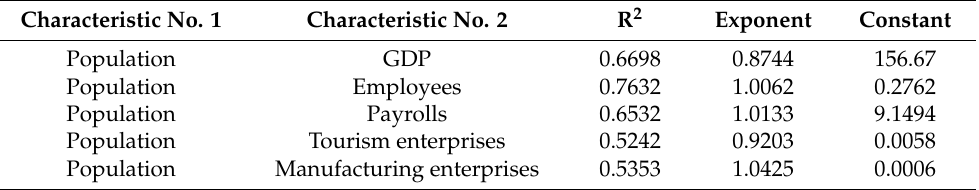
Figure 1. The 2016 association between population numbers and enterprise numbers in United States micropolitan statistical areas. Table 2. Power-law associations between population numbers and different economic and en- trepreneurial characteristics of United States